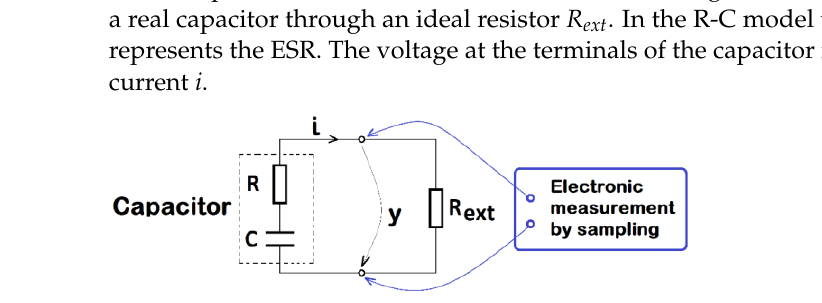
Figure 9. The analysed circuit.